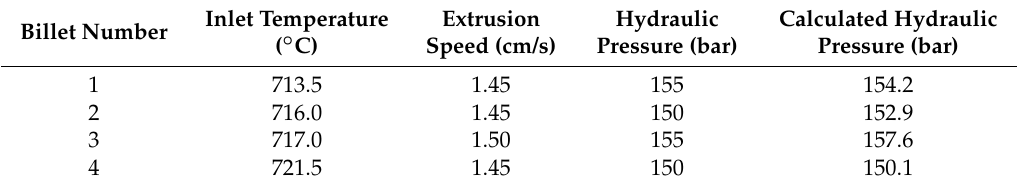
Table 5. Validation experiments in the production process. The measurements of the hydraulic pressure are juxtaposed with the model results. The measured hydraulic pressure is obtained via a pressure gage with an estimated precision of 2.5 bar. The inlet temperature is the average of three measurements at the front, middle and back of the billet, using an optical pyrometer with estimated precision of 0.5 ◦ C. Inlet Temperature Extrusion Billet Number ( ◦ C) Speed